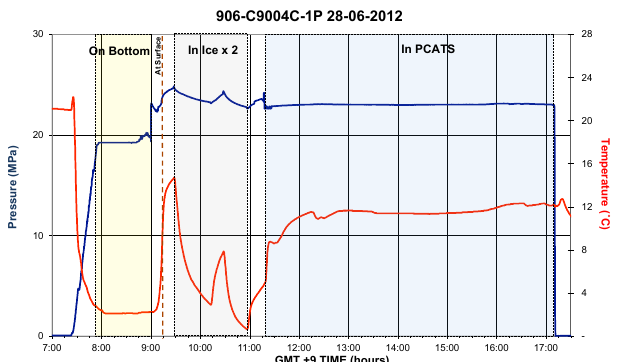
Figure 2. Pressure and temperature log from core C9004C-1 show- ing that the pressure in the autoclave was kept higher than the in situ pressure through retrieval, onboard handling and